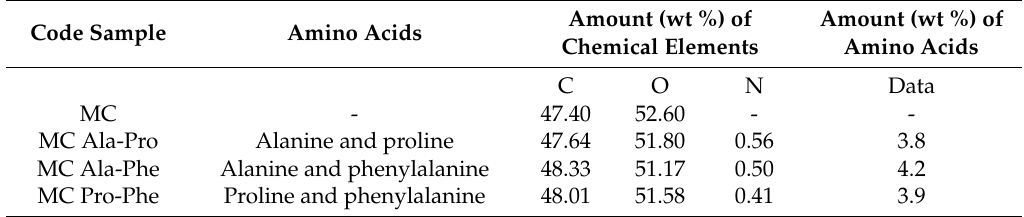
Table 1. Elemental analysis of the untreated and amino acid-treated samples of cellulose. Code